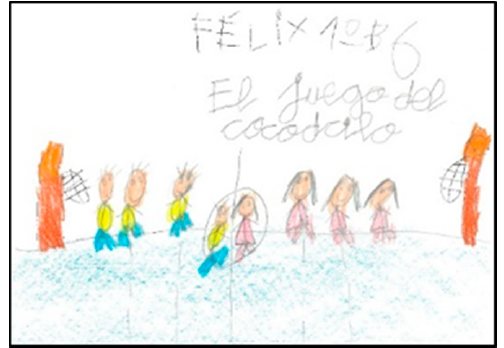
Figure 11. Clothes they identify with. Irene. 2 ◦ A.